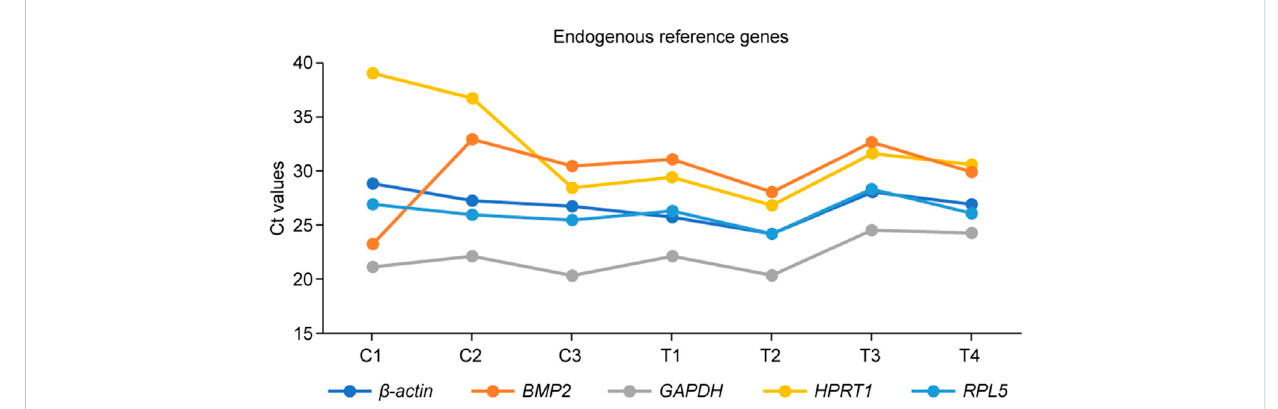
FIGURE 3 The threshold cycle (Ct) values for the fi ve endogenous reference genes tested before use in the summer of 2021. C1 – C3: retina collected from control (indoor) chicks, T1 – T4: retina collected from heat-treated (outdoor)